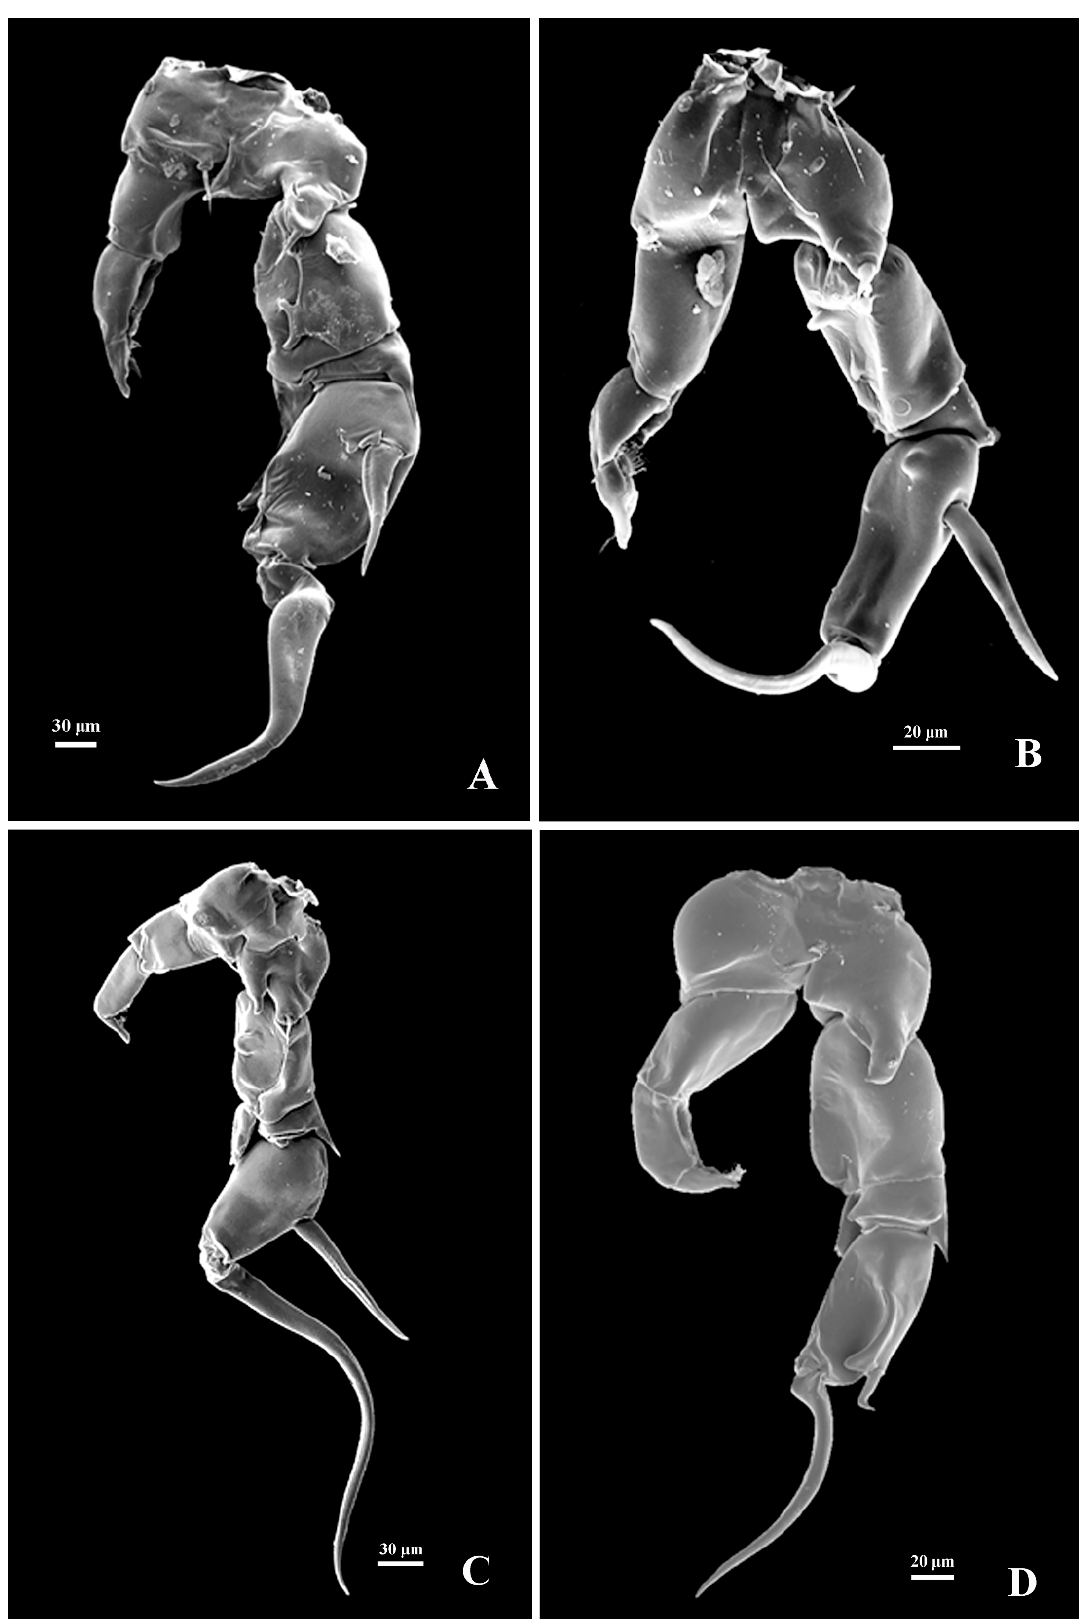
Figure 8. SEM photographs of the male leg 5 (P5) of four species of the diaptomid copepods: ( A ) Vietodiaptomus blachei ; ( B ) Heliodiaptomus elegans ; ( C ) Neodiaptomus schmackeri ; and ( D ) Dentodiaptomus javanus.